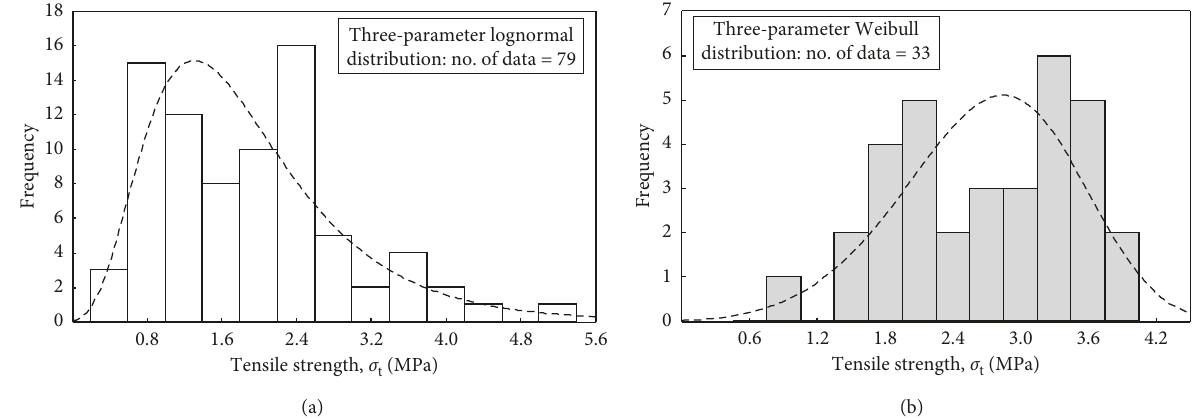
Figure 4: (a) Three-parameter lognormal distribution of the tensile strength for cement mortar and (b) 3-parameter Weibull distribution of the tensile strength for cement mortar modified with fly ash (FA) up to 90 days of curing.